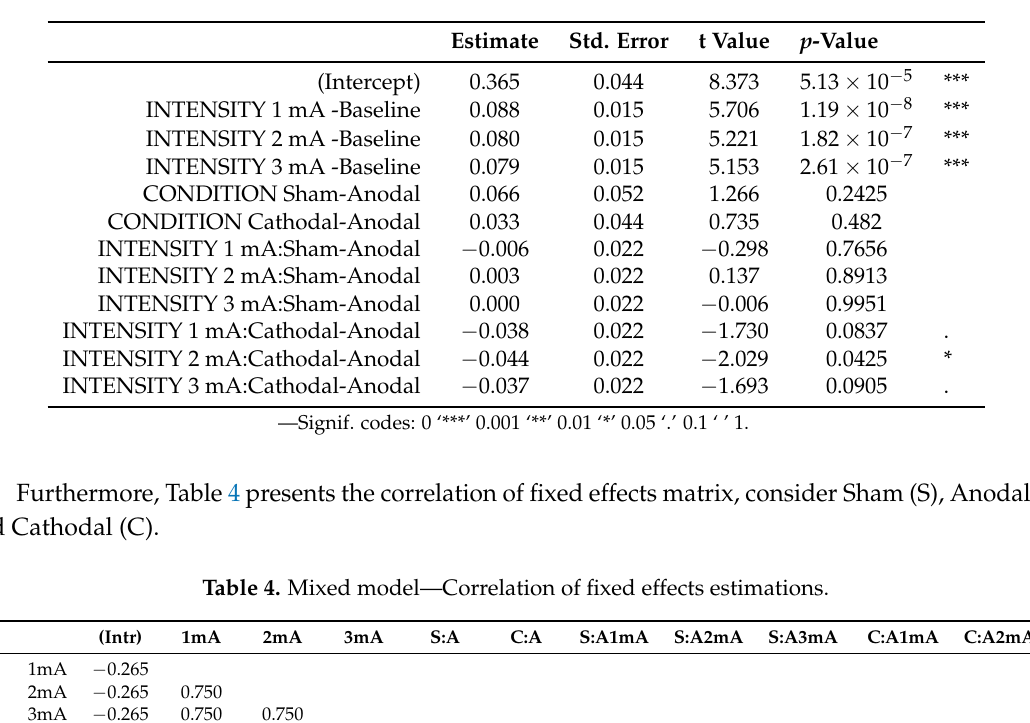
Table 3. Mixed model—Fixed effects estimations.